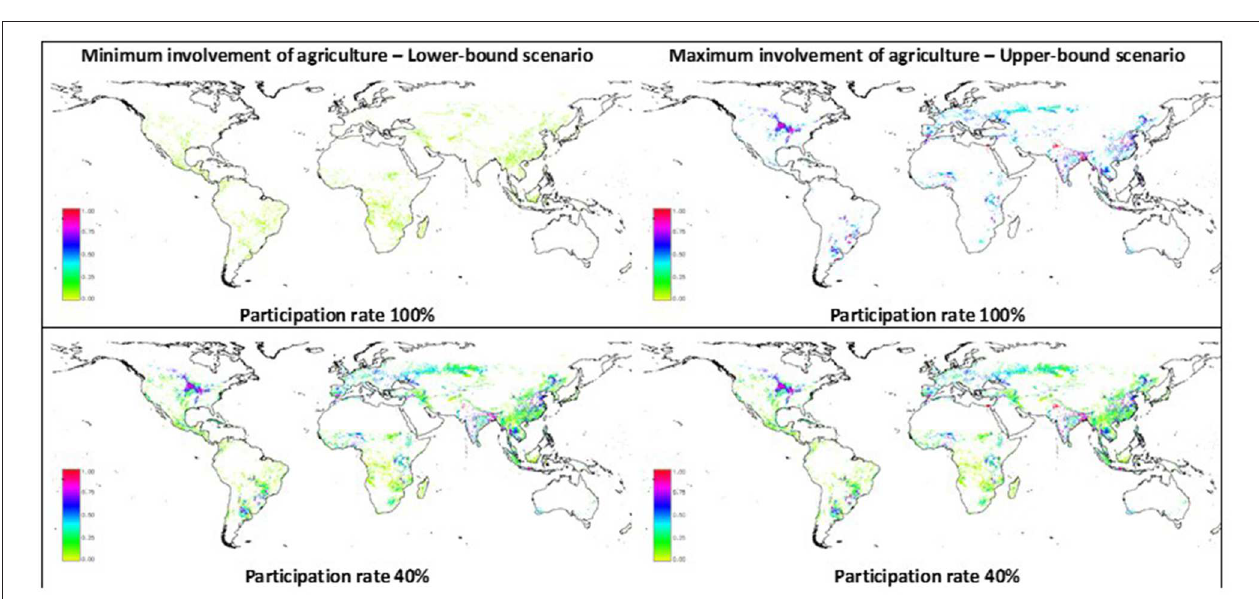
FIGURE 3 | BAU scenario: 2010–2030—Changes in production, prices, undernourished children, and population at risk of hunger.